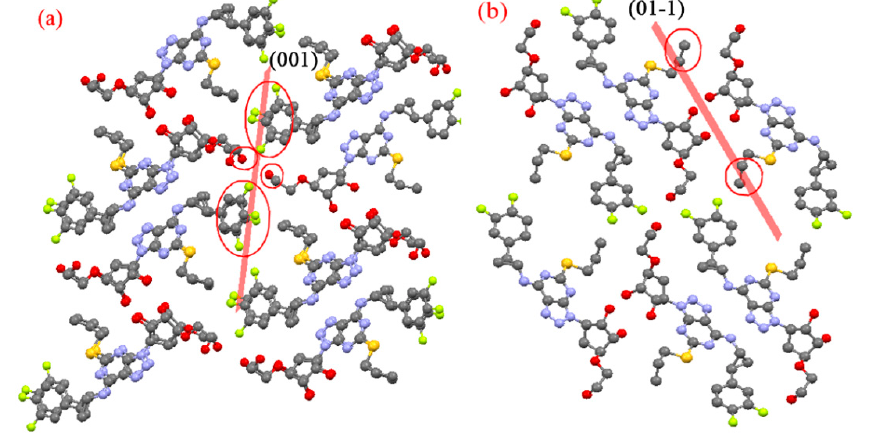
Figure 10. ( a ) Packing along (001) face and ( b ) (01-1) face, showing the surface chemistry.